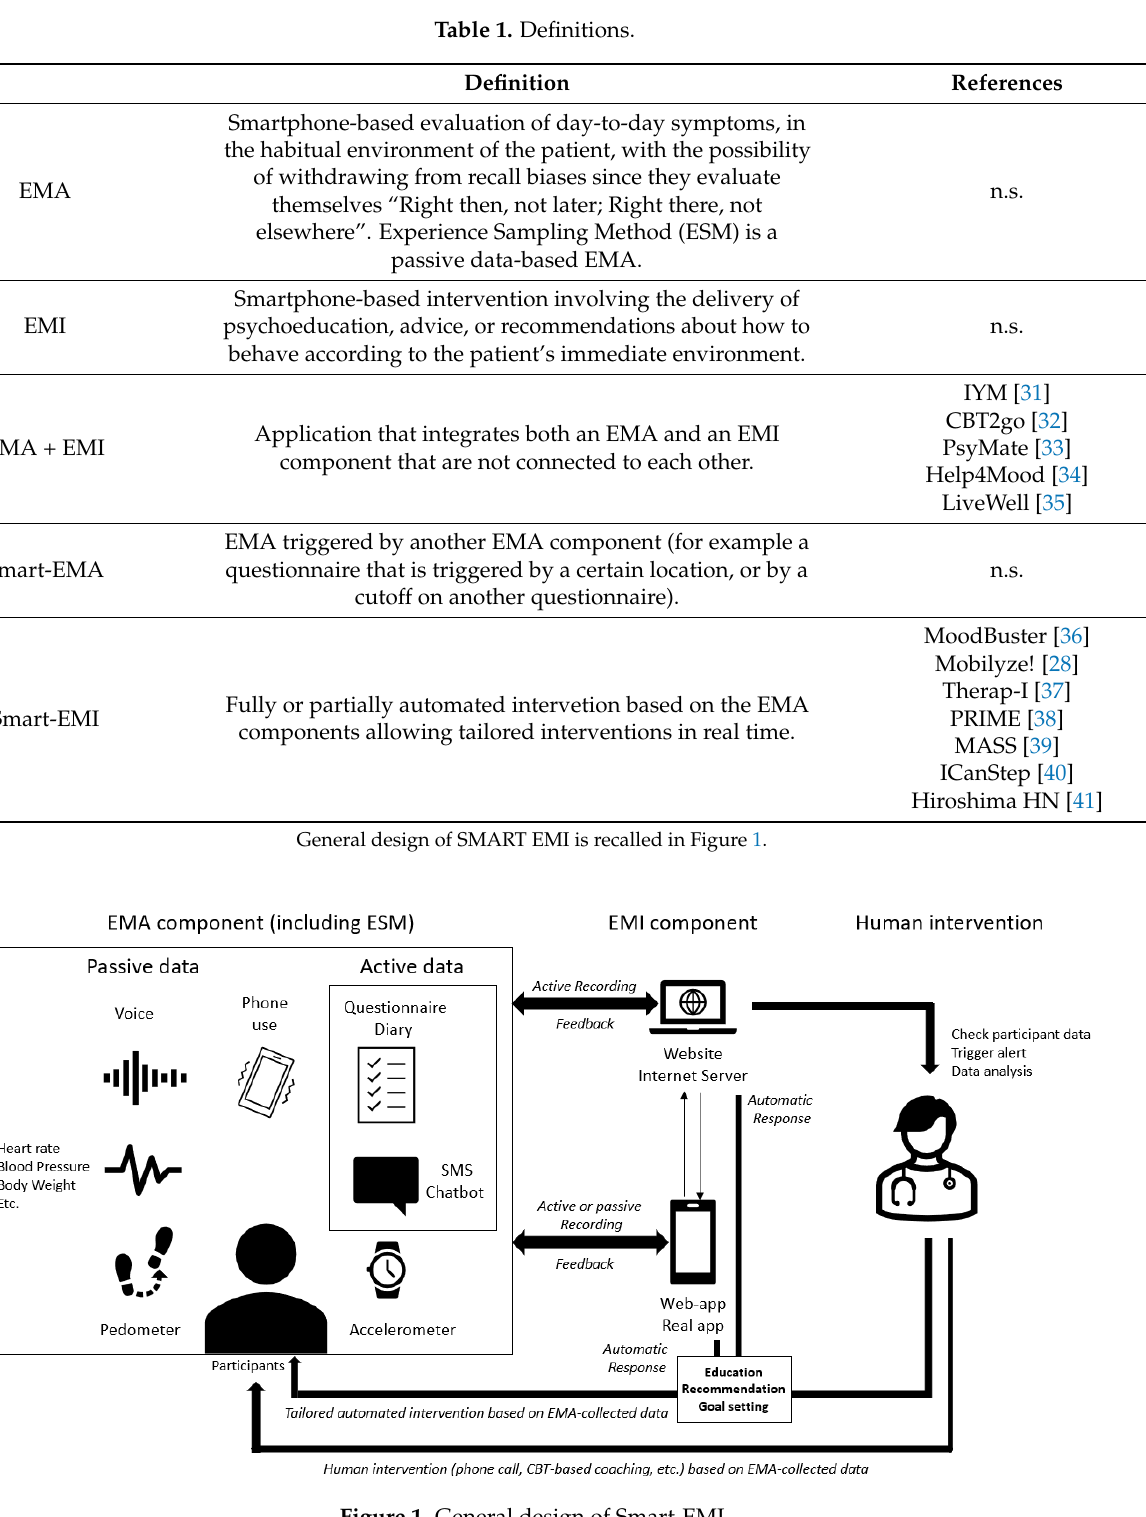
Figure 1. General design of Smart-EMI. Real life training (“in situ”) appears highly relevant for learning or to regain healthy be- haviors, since depressed people regularly switch from goal-directed behavior to habits